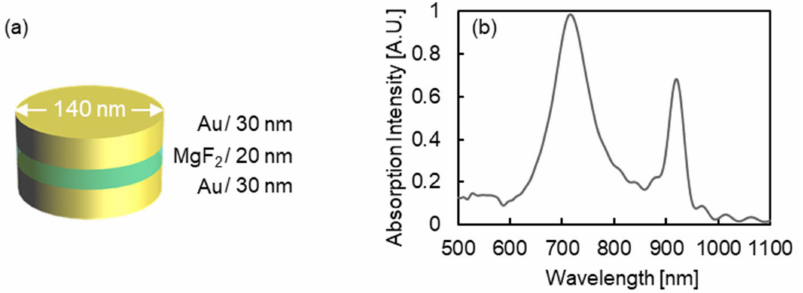
Figure 3. ( a ) Structure and ( b ) absorption spectrum of designed MIM nanostructures. As shown in ( a ), the MIM nanostructures were designed as follows: 30 nm of Au layer thickness; 20 nm of MgF 2 thickness; and 140 nm of